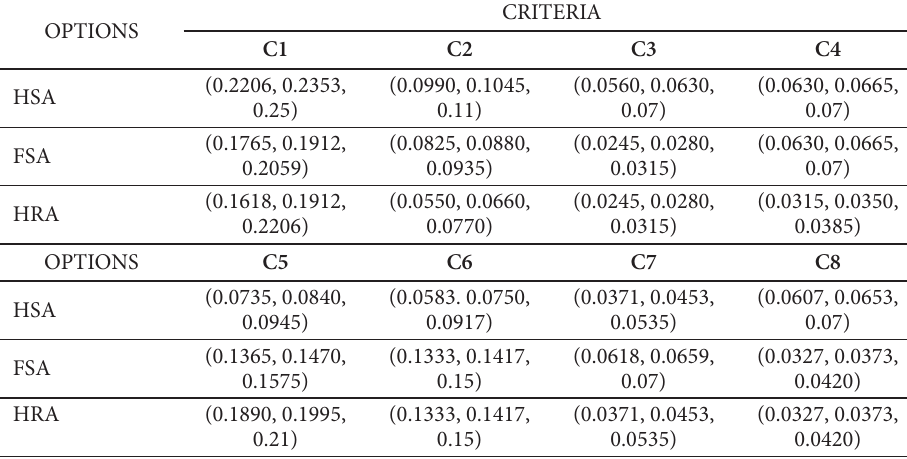
Table 7. Fuzzy weighted normalized decision